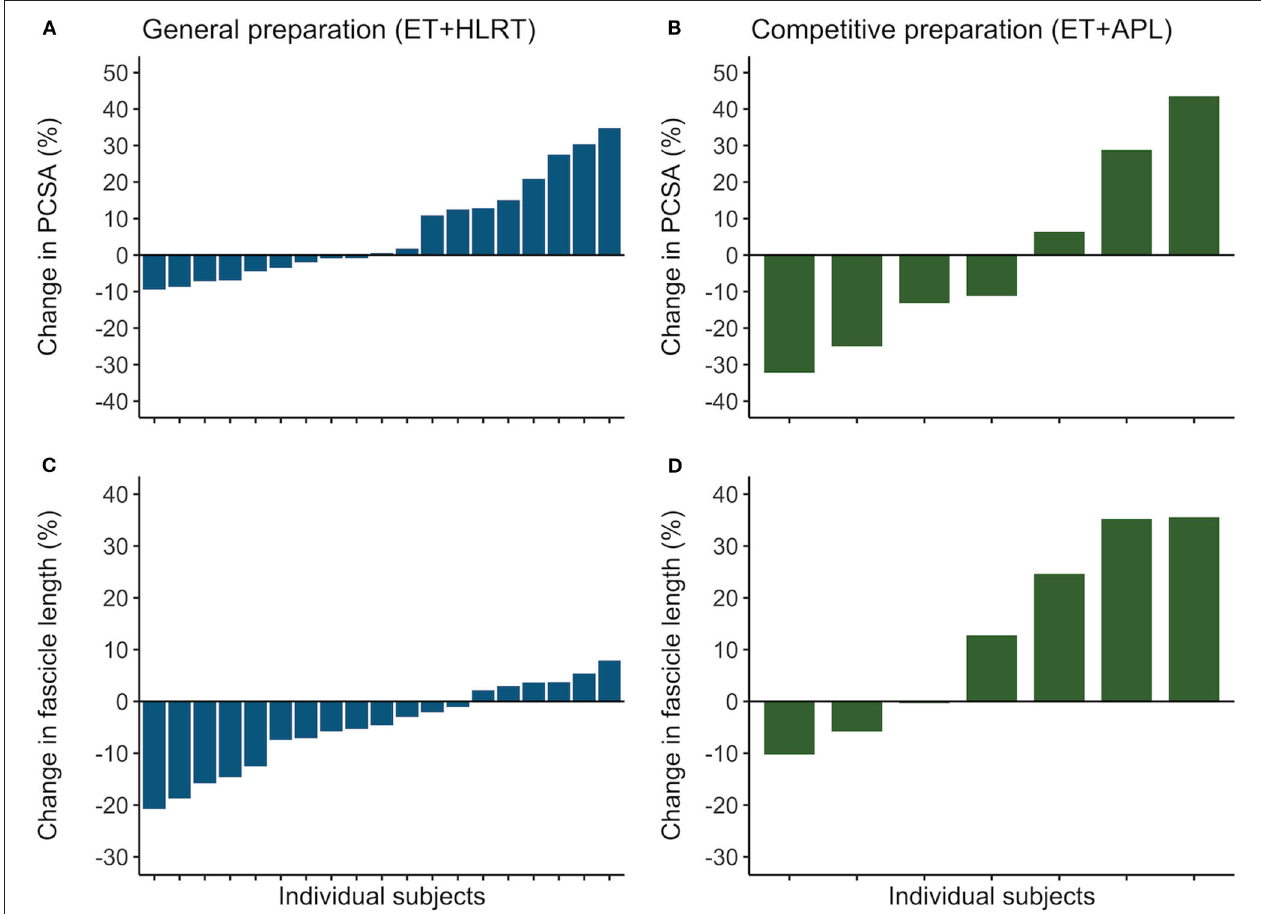
FIGURE 3 | Individual training adaptations during the general and competitive preparation phases in elite female rowers. Percentual changes in vastus lateralis (A) PCSA and (C) fascicle length are shown for the individual rowers during the general preparation phase. In a subgroup of rowers, percentual changes are reported for (B) PCSA and (D) fascicle length during the competitive preparation phase. ET, endurance training; HLRT, high-load resistance training; APL, high-load resistance training with additional plyometric